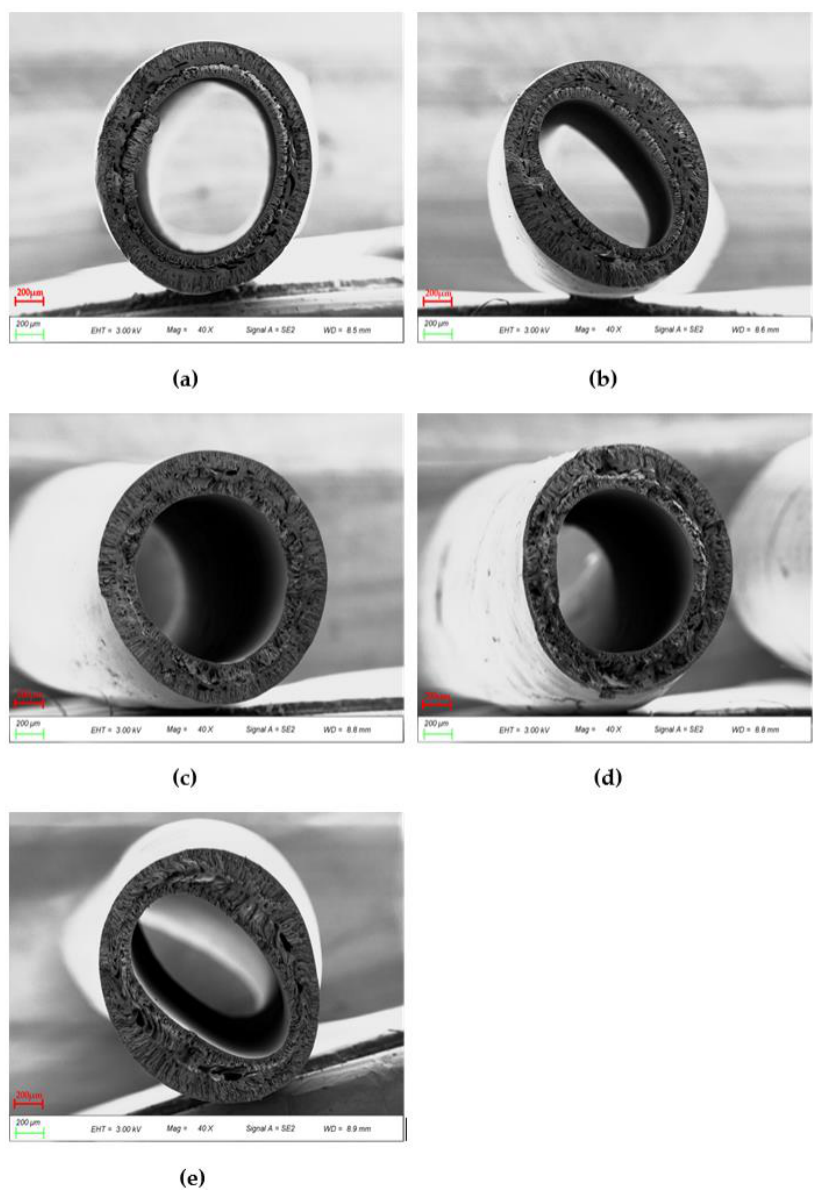
Figure 9. 40 × SEM images of cross sections of various PES/PEI membranes: ( a ) PP-1; ( b ) PP-2; ( c ) PP-3; ( d ) PP-4; ( e ) PP-5.